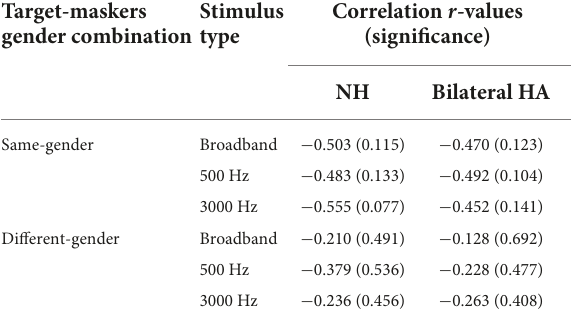
TABLE 3 Regression coefficients between spatial release from masking (SRM) and localization acuity for NH and bilateral HA user groups in each stimulus and gender-combination